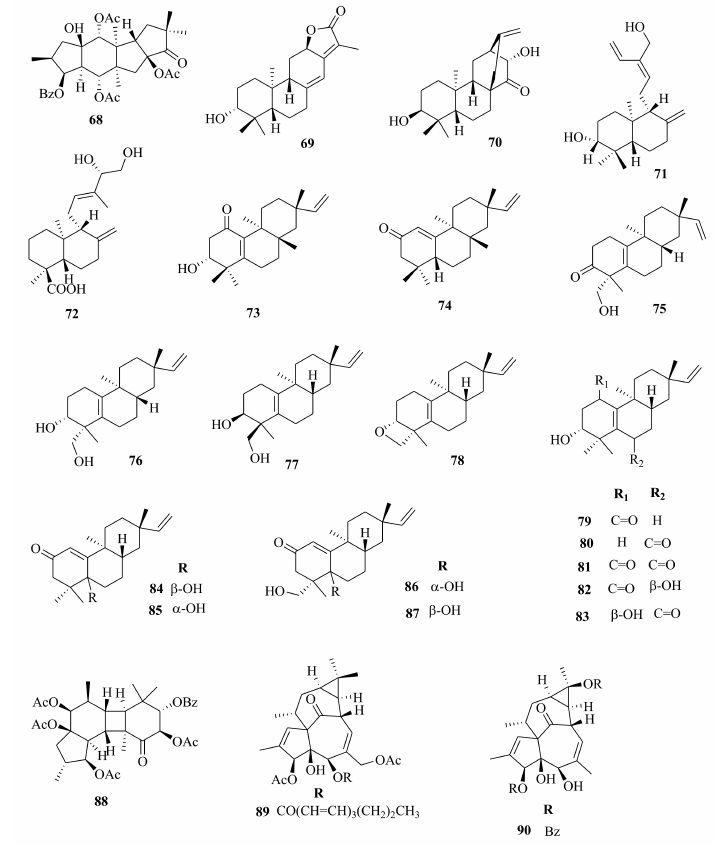
Figure 4. Chemical structures of ent-labdane, ent-rosane and gaditanone